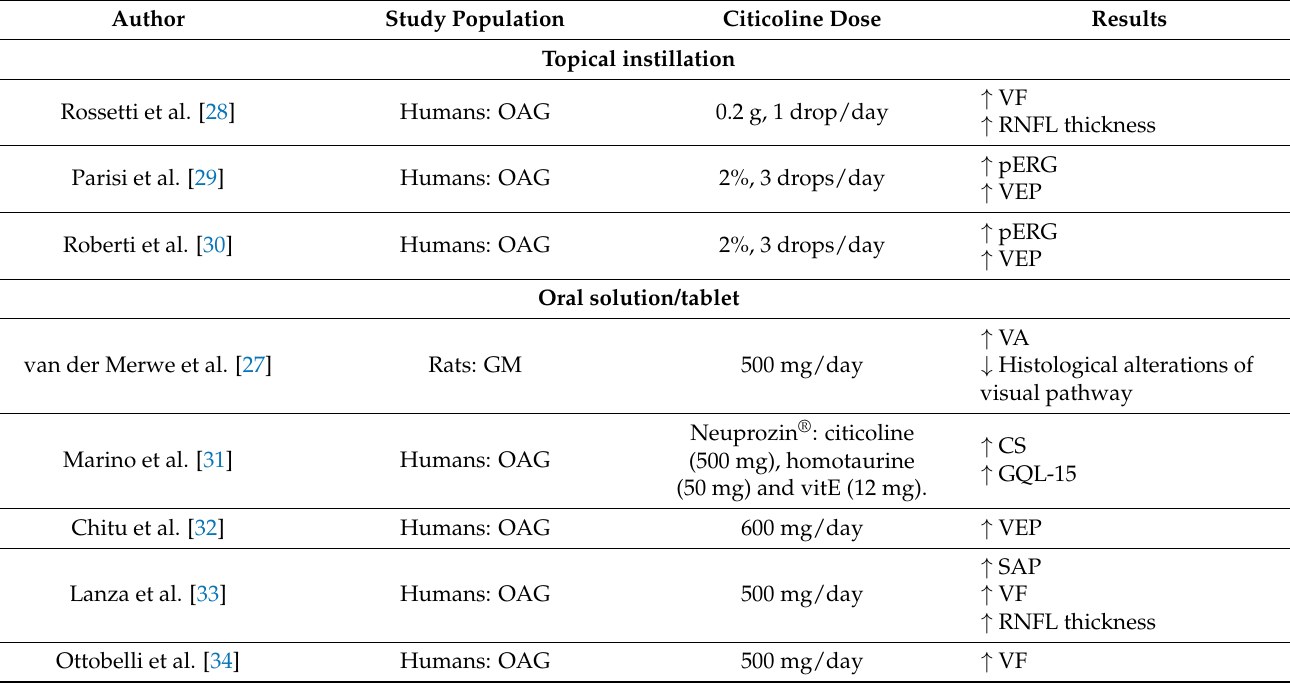
Table 1. Summary of articles that relate citicoline to glaucoma, classified according to administra- tion